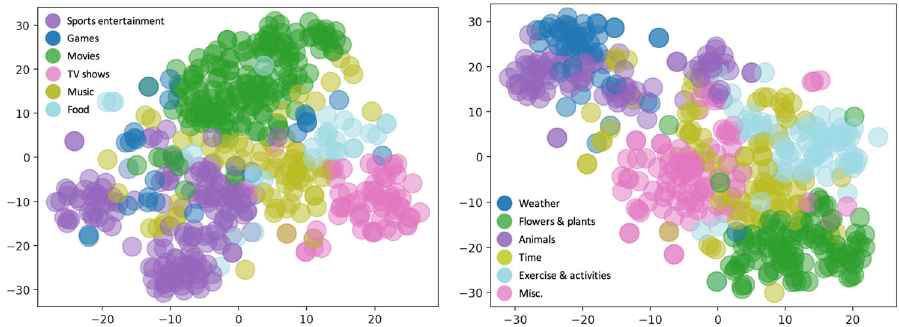
Fig. 8 Clusters for LEISURE (left) and NATURE (right). While leisure-related happy moments mainly focus on visual entertainment, in NATURE we fi nd references to happiness as dependent on the weather, as well as the fl ora and fauna. Table 3 Sources of happiness shared by HappyDB categories.